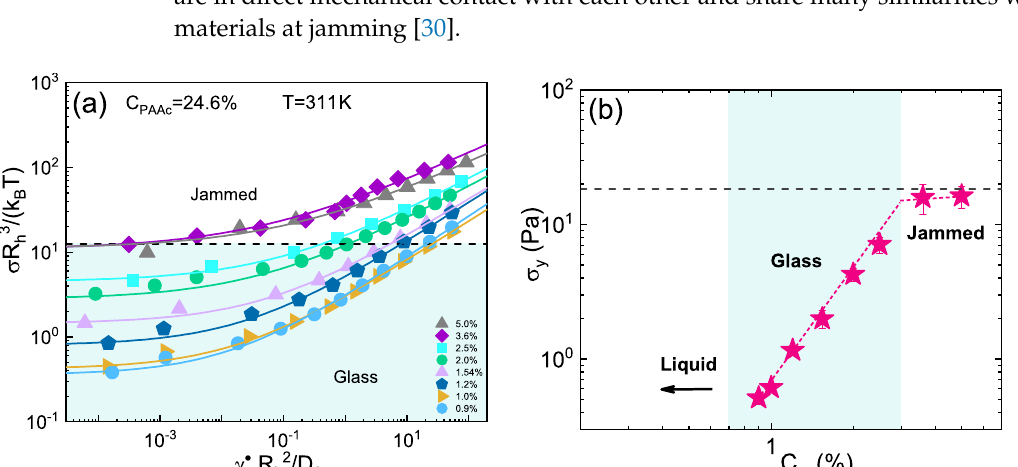
Figure 4. ( a ) Normalized stress versus Peclet number. Lines are fits following the Herschel-Bulkley model. ( b ) Apparent yield stress (pink stars), obtained from the Herschel-Bulkley fit to data in (a), versus weight concentration for IPN with C PAAc = 24.6% at T = 311K. The black dashed lines represent the value σ y R 3 /(k B T ) = 12.5 it is considered the value that nearly marks the border between glass and jammed state as described in the